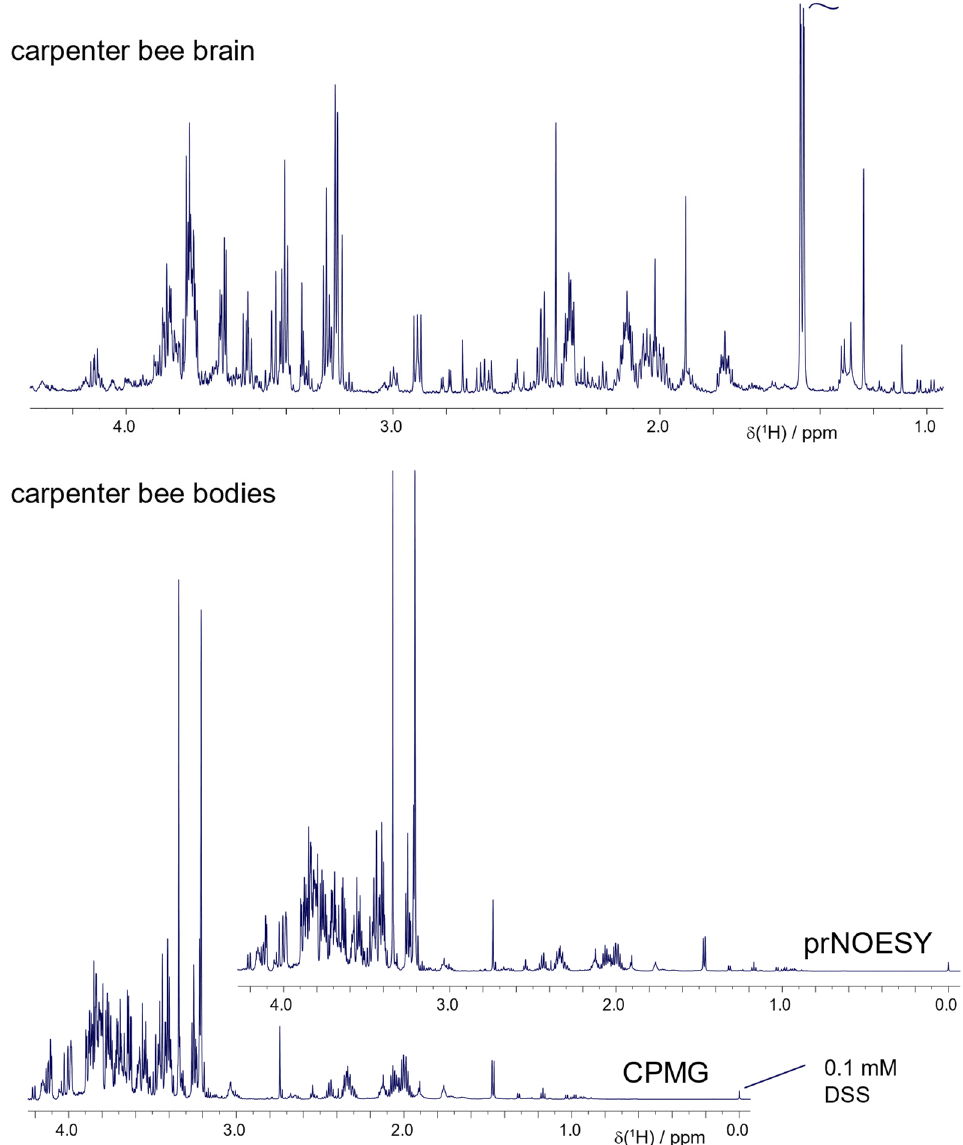
Figure 8. Larger bees, notably the carpenter bee, are particularly amenable to extraction and NMR analysis, where rich metabolite recovery was obtained from both a body and a brain. The typical 0.1 mM DSS standard concentration may not be optimal. Here, the chloroform:methanol approach was employed. The CPMG method results in highly similar spectra to pr-NOESY, supporting that the chloroform:methanol extract, although inefficient, has effectively suppressed proteins and lipids.